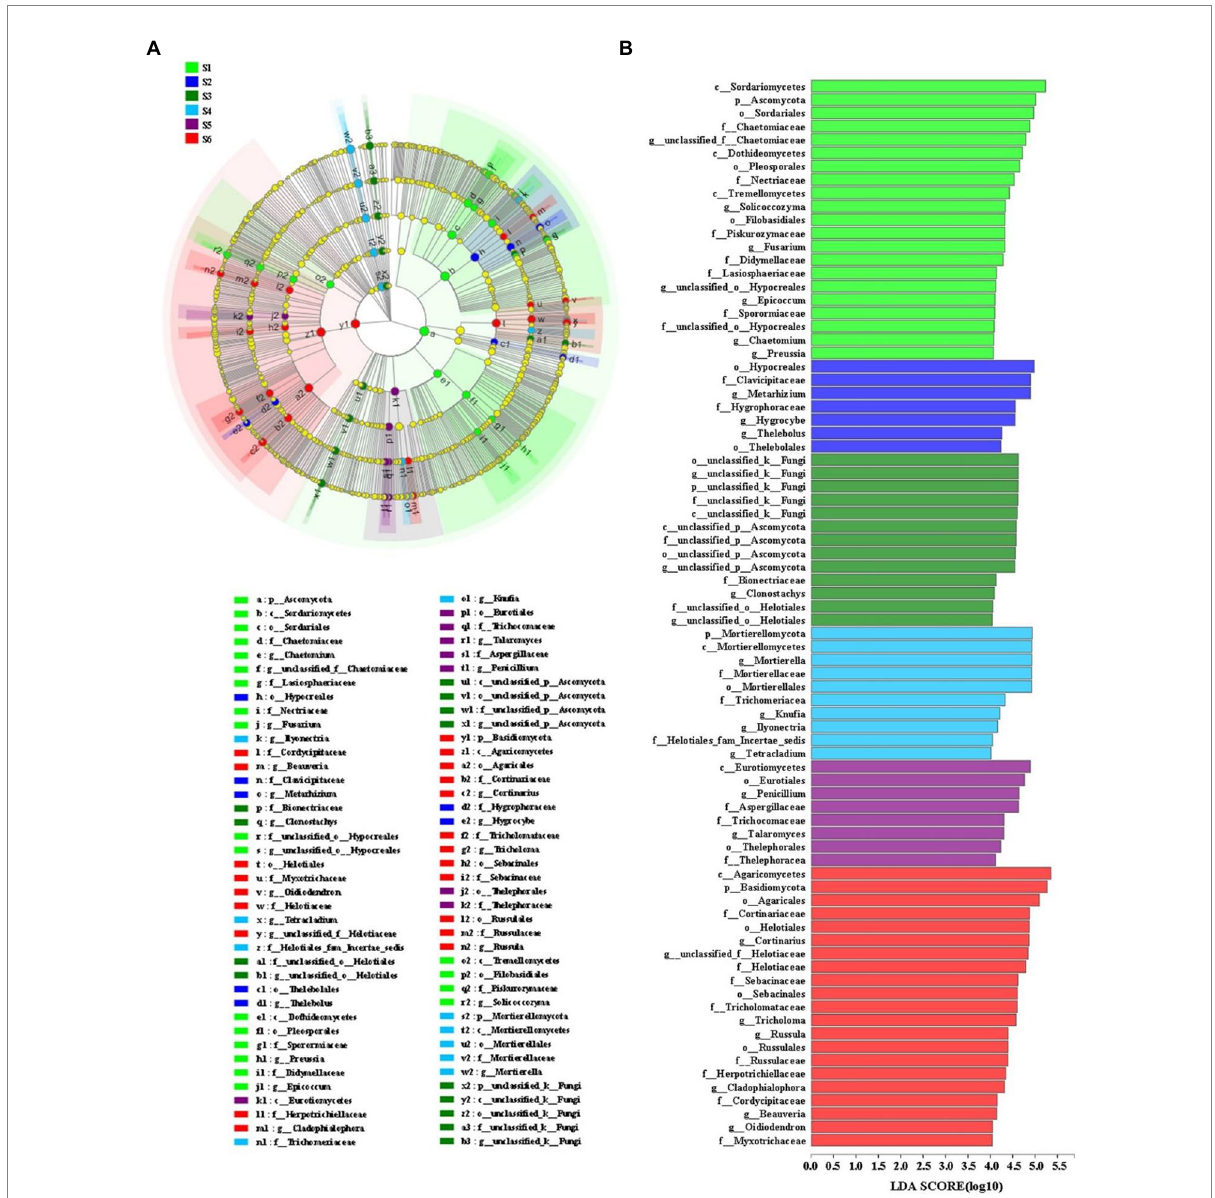
FIGURE 3 (A) Cladogram indicating the phylogenetic distribution of microbial lineages associated with six different restoration stages on the Loess Plateau, China; (B) lineages with LDA values of 4.0 or higher determined by LEfSe are displayed. Differences are represented by the color of the most abundant microbial groups (in Figure 3, emerald green indicates farmland stage (S1), dark blue indicates pioneer weed stage (S2), dark green indicates herbage stage (S3), sky blue indicates shrub stage (S4), dark purple indicates early forest stage (S5), red indicates climax forest stage (S6), and yellow indicates non-significant). Each circle’s diameter is proportional to the abundance of the taxon. Circles represent phylogenetic levels from phylum to genus, from the inside